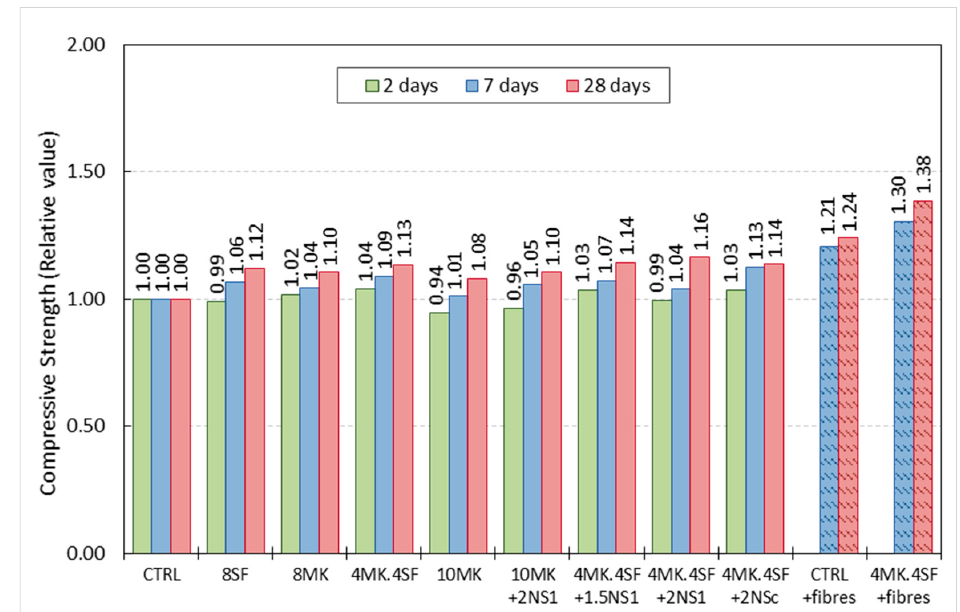
Figure 6. Relative increment of strength. CTRL mix results are taken as the unity at two, seven and 28 days of age for